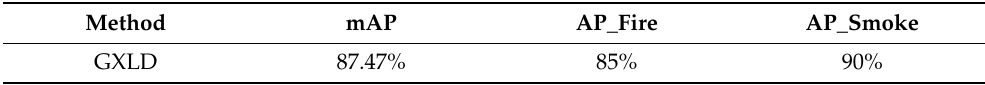
Table 9. The performance of GXLD for forest fire